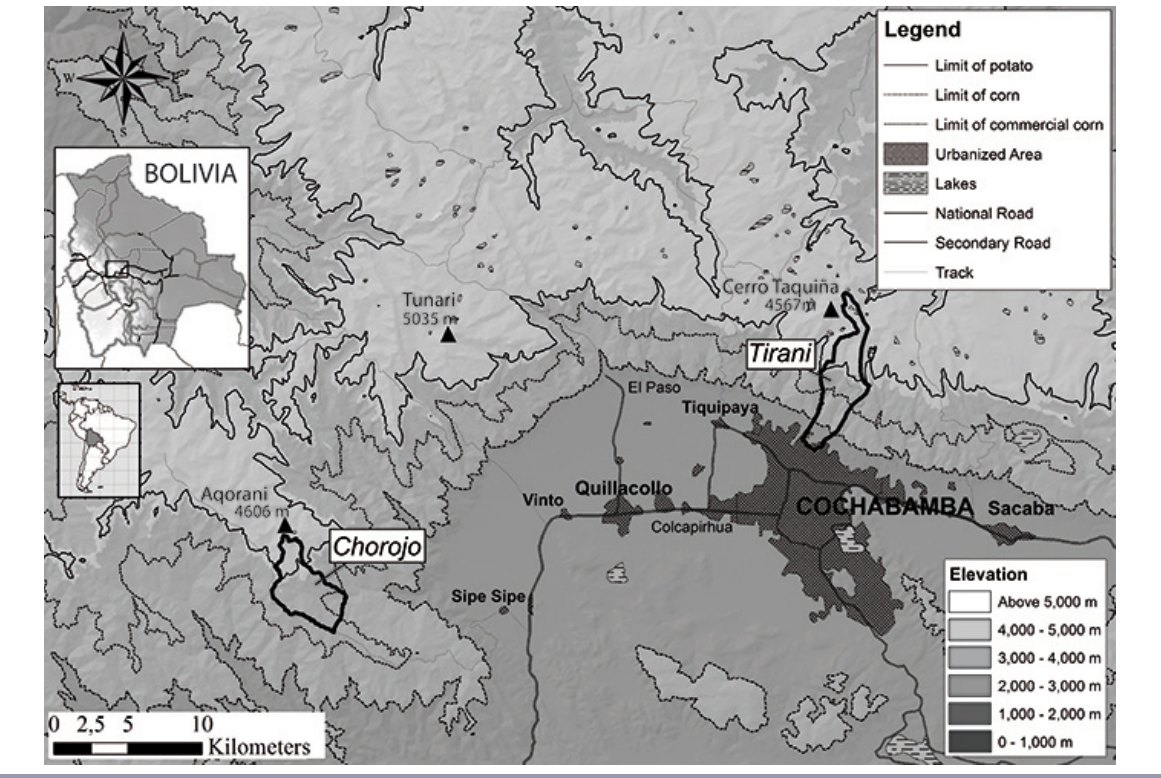
Fig. 1 . Location of the area of study with the communities of Chorojo and